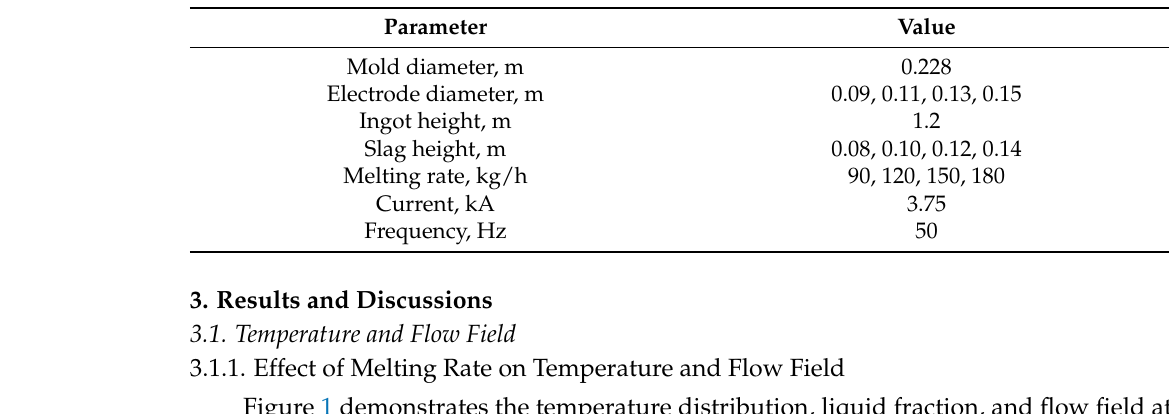
Table 2. Melting parameters used in